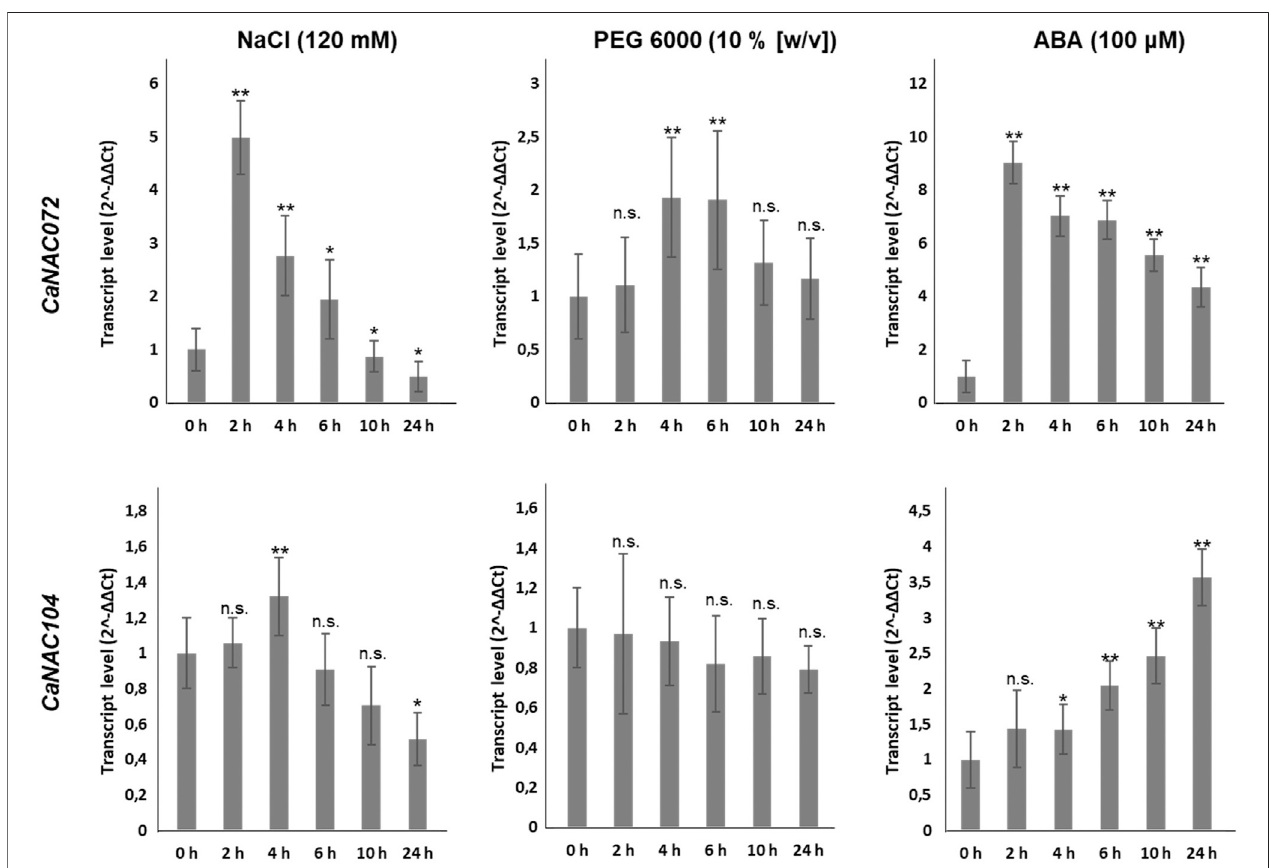
FIGURE 6 | Transcript levels of CaNAC072 and CaNAC104 after stress treatments. Gene expression was quanti fi ed by qRT-PCR after 0, 2, 4, 6, 10 and 24 h of treatments with NaCl, PEG and ABA. Ten-day-old seedlings were transferred to liquid MS media containing 120 mM NaCl, 10% (w/v) PEG 6000, or 100 μ M ABA. Data represent the means ± SD ( n (cid:1) 3 biological replicates). Pepper actin and GADPH genes were used as the reference genes. Asterisks (*) indicate statistically signi fi cant differences between control condition (0 h of treatment) and stress treatment according to Student ’ s t -test; *, p < 0.05; **, p < 0.01; n.s. not signi fi cant.